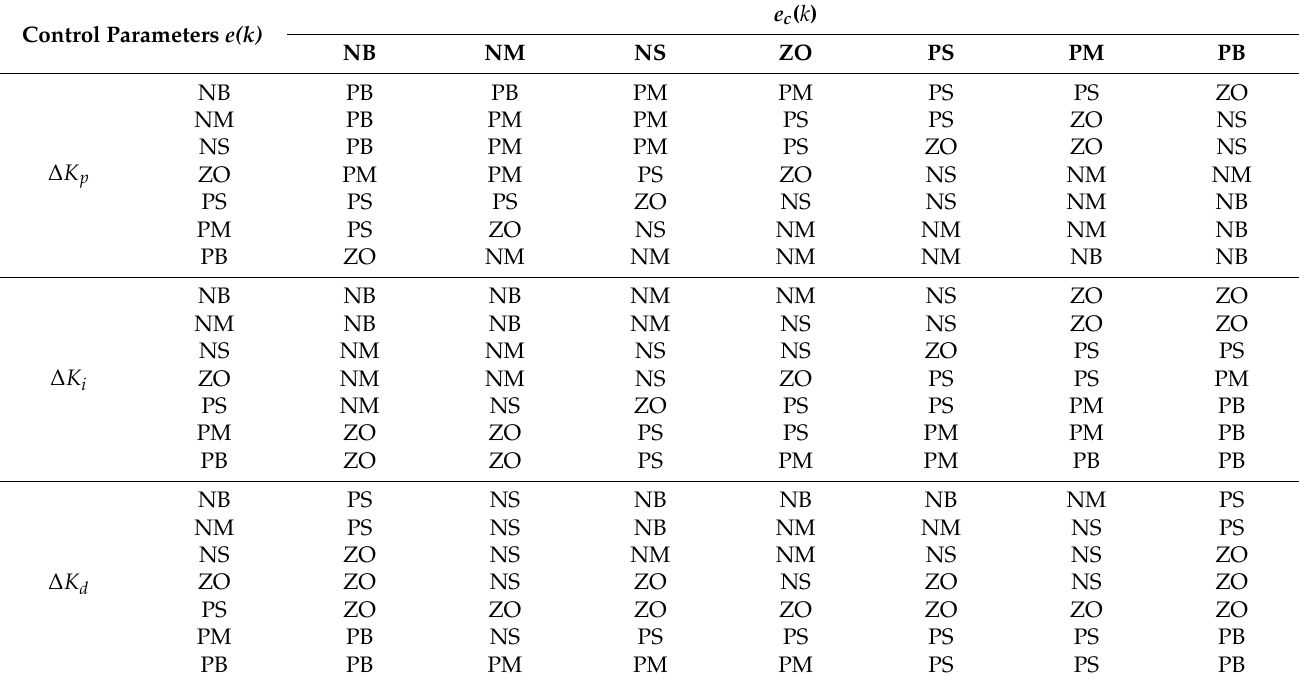
Table 3. Fuzzy control table for ∆ K p , ∆ K i and ∆ K d